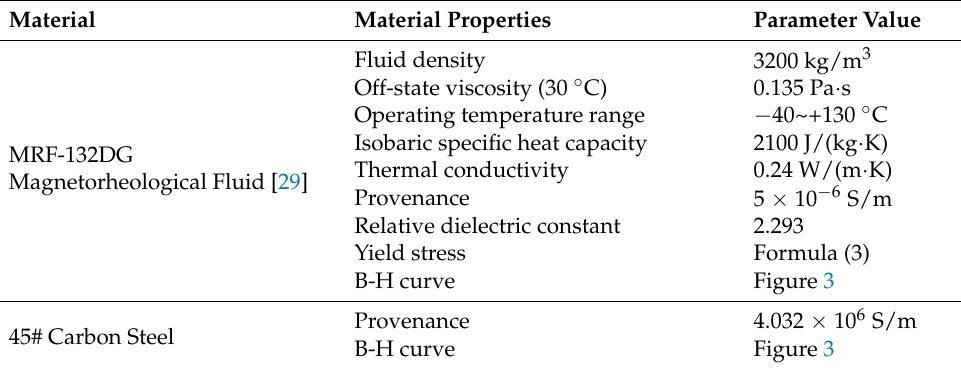
Figure 4. Influence of temperature on viscosity and yield stress of Magnetorheological Fluid. ( a ) Influence of temperature on the viscosity of Magnetorheological Fluid; ( b ) effect of temperature on yield stress of Magnetorheological Fluid. Polynomial fitting was performed on the test data in Figure 4 so as to obtain the fit- ting formula of the influence of temperature on the viscosity and yield stress of Magne- torheological Fluid under different current conditions, which is shown in Formula (4). 2